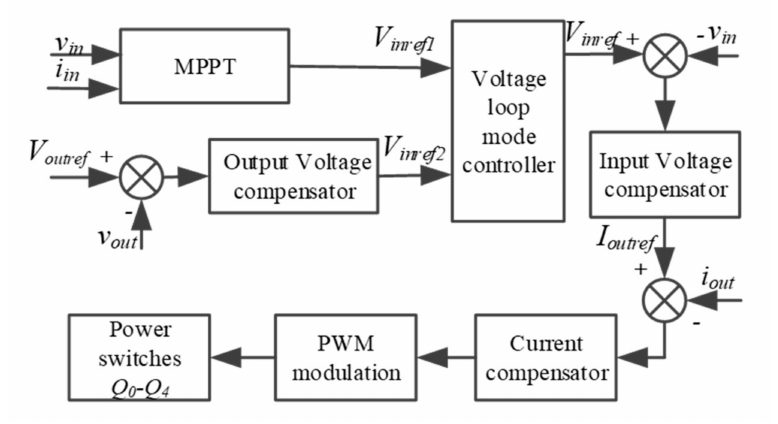
Figure 13. Control strategy for PV MVDC